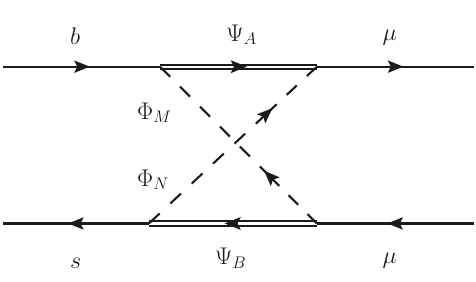
Figure 9 . Crossed box diagrams contributing to b ! s(cid:22) + (cid:22) (cid:0) transitions. The diagram appears when a complex scalar couples to b; s quarks and its conjugate couples to the muons.